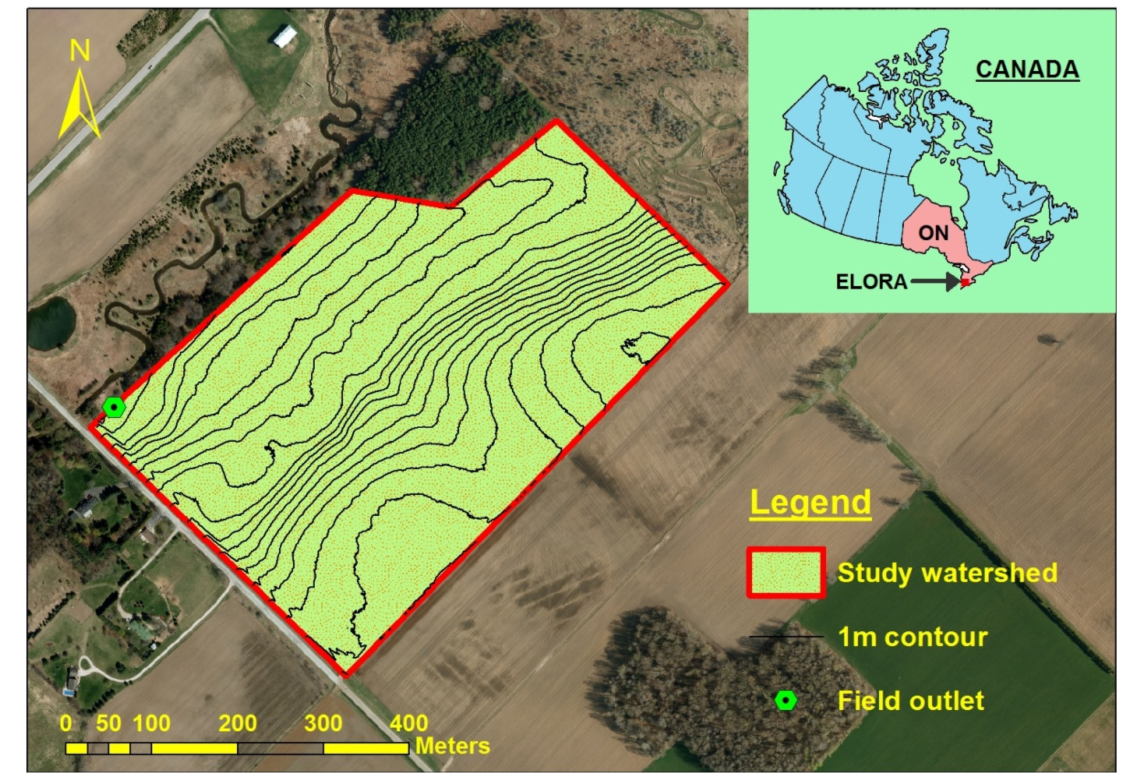
Figure 1. The layout of the study watershed at Elora Research Centre, Elora